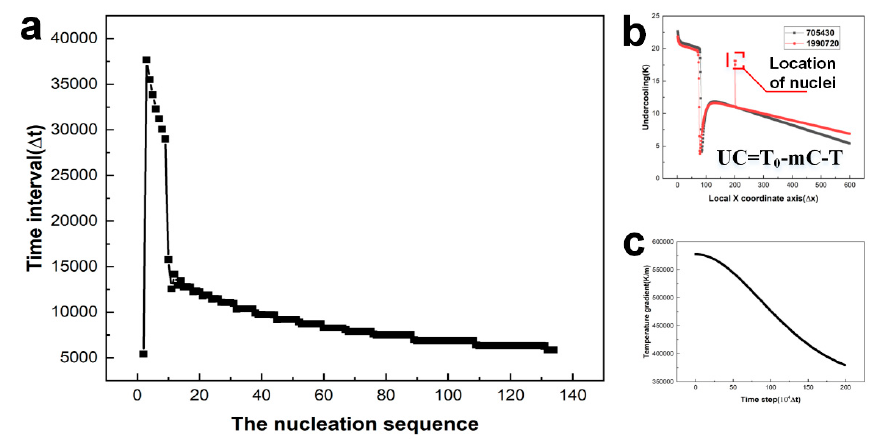
Figure 20. ( a ) The time interval of each row of equiaxed-grain formation; ( b ) undercooling distribution when seeds nucleate; ( c ) temperature gradient variation with time.